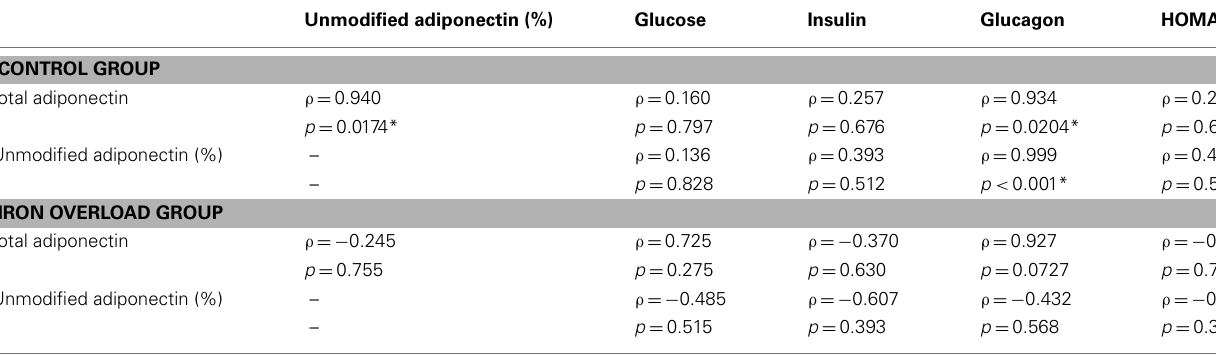
Table 4 | Pearson product moment correlations ( ρ ) of variables within groups in the 2h post-prandial sample